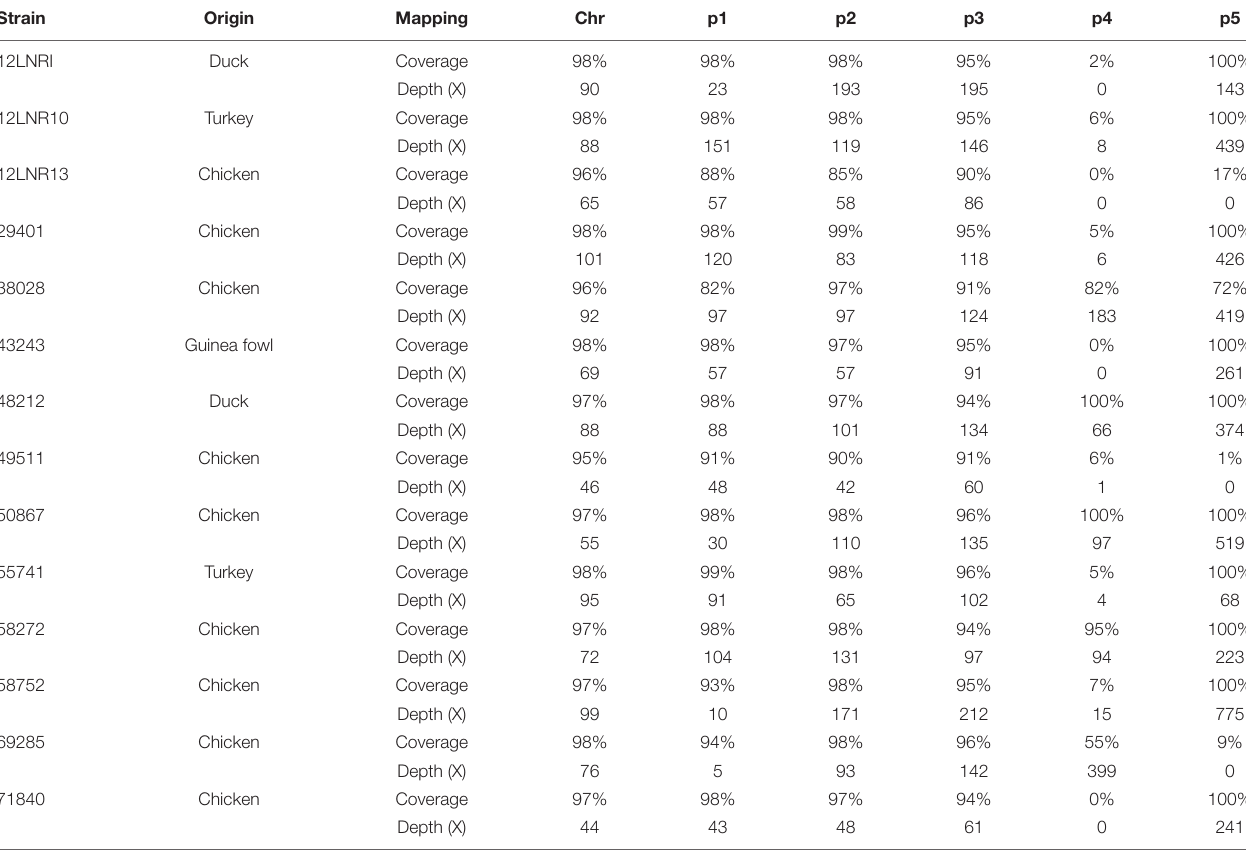
TABLE 1 | Clostridium botulinum type C/D mapping assembly